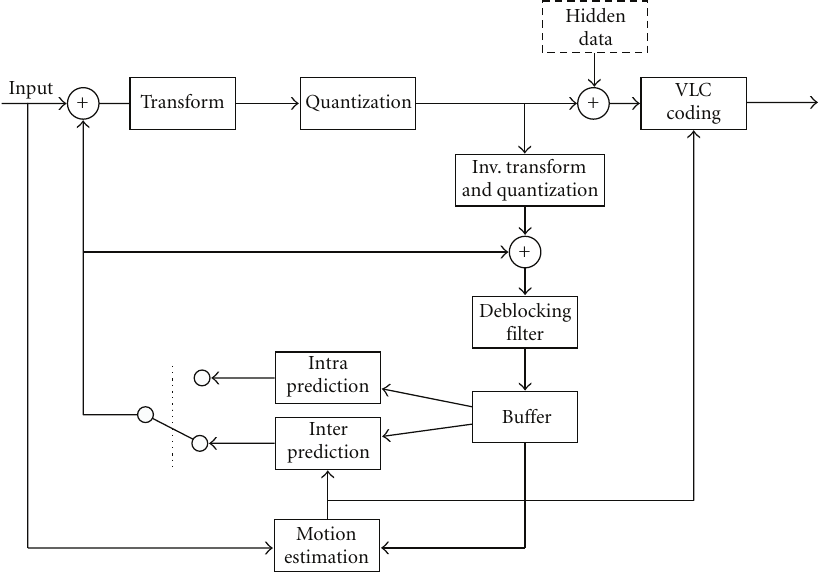
Figure 3: The proposed ROI data hiding scheme.